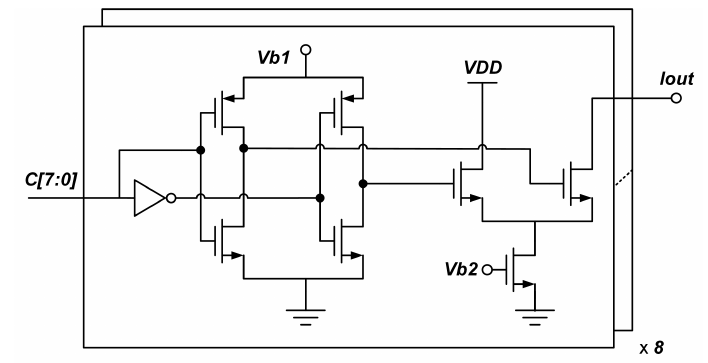
Figure 9. Circuit of the DAC adopted in the DTC.